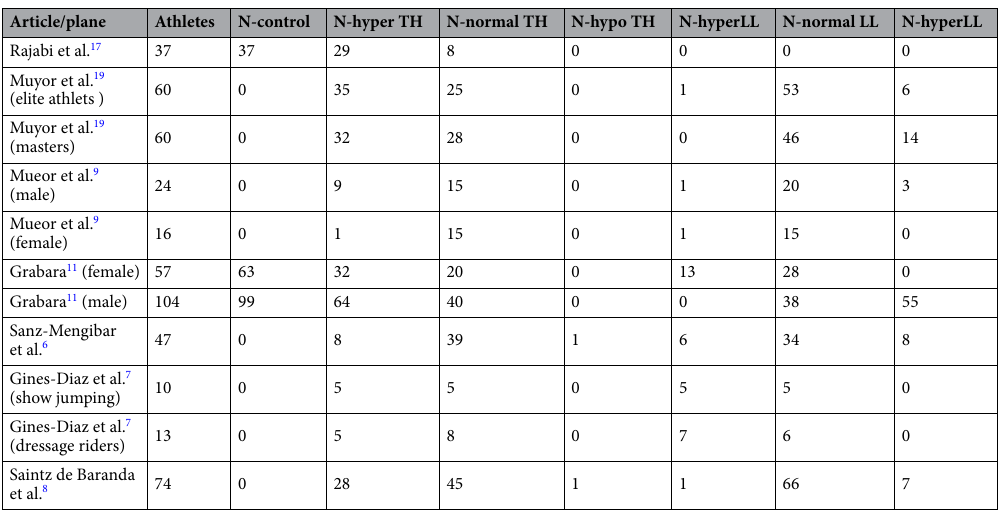
Table 3. General characteristics of articles that were used to build meta-analysis models of proportions to combine data: the sagittal plane. TH thoracic kyphosis, LL lumbar lordosis.